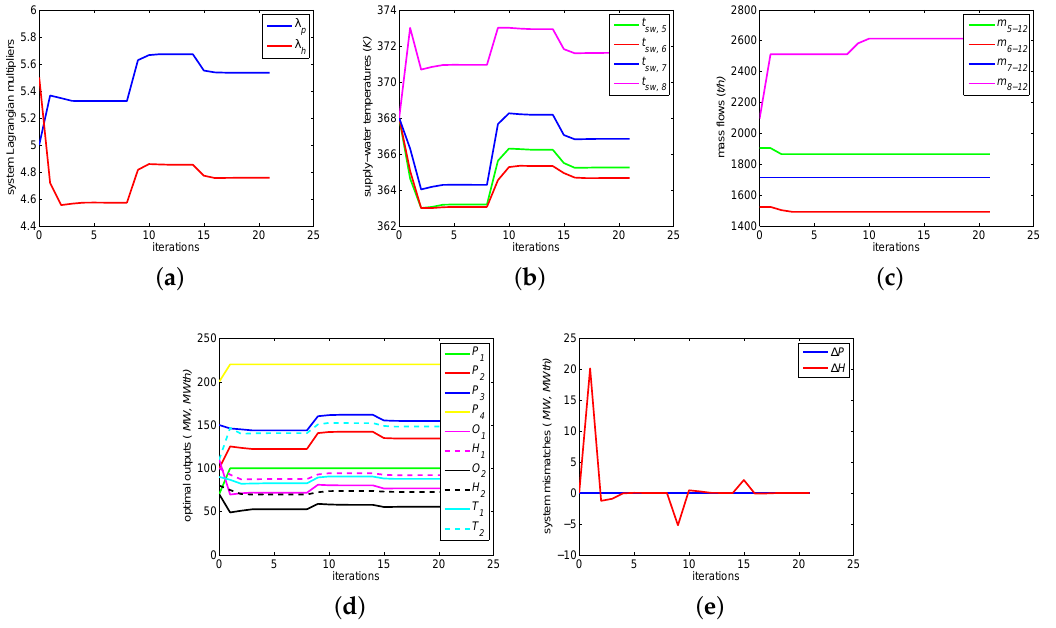
Figure 7. Case study 4: With load fluctuation demand. ( a ) system Lagrangian multipliers; ( b ) supply-water temperatures; ( c ) mass flows; ( d ) optimal outputs; ( e ) system